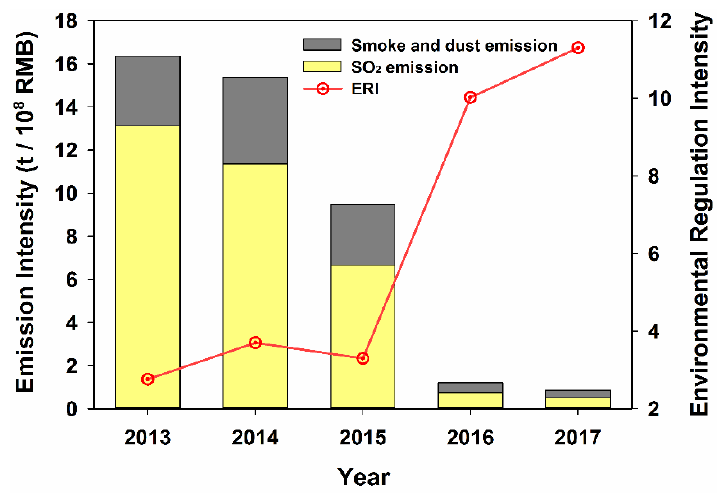
Figure 4. Environmental regulation intensity and the emission intensity of SO 2 , smoke, and dust.